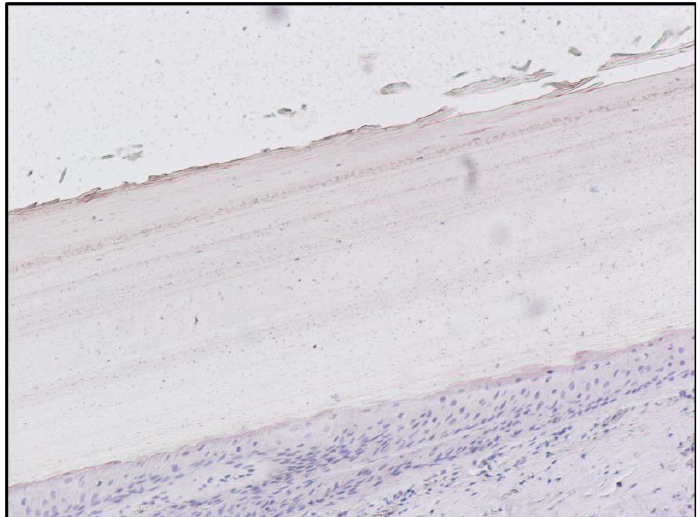
Figure 3. Immunoperoxidase staining for Sheep Anti-Morphine in the fingernail of Subject A, 10× magnification. The immunohistochemistry protocol has been modified to observe the presence of any non-specific reaction; in this figure the primary antibody has been used, while the secondary antibody conjugated to the peroxidase enzyme has not been used.